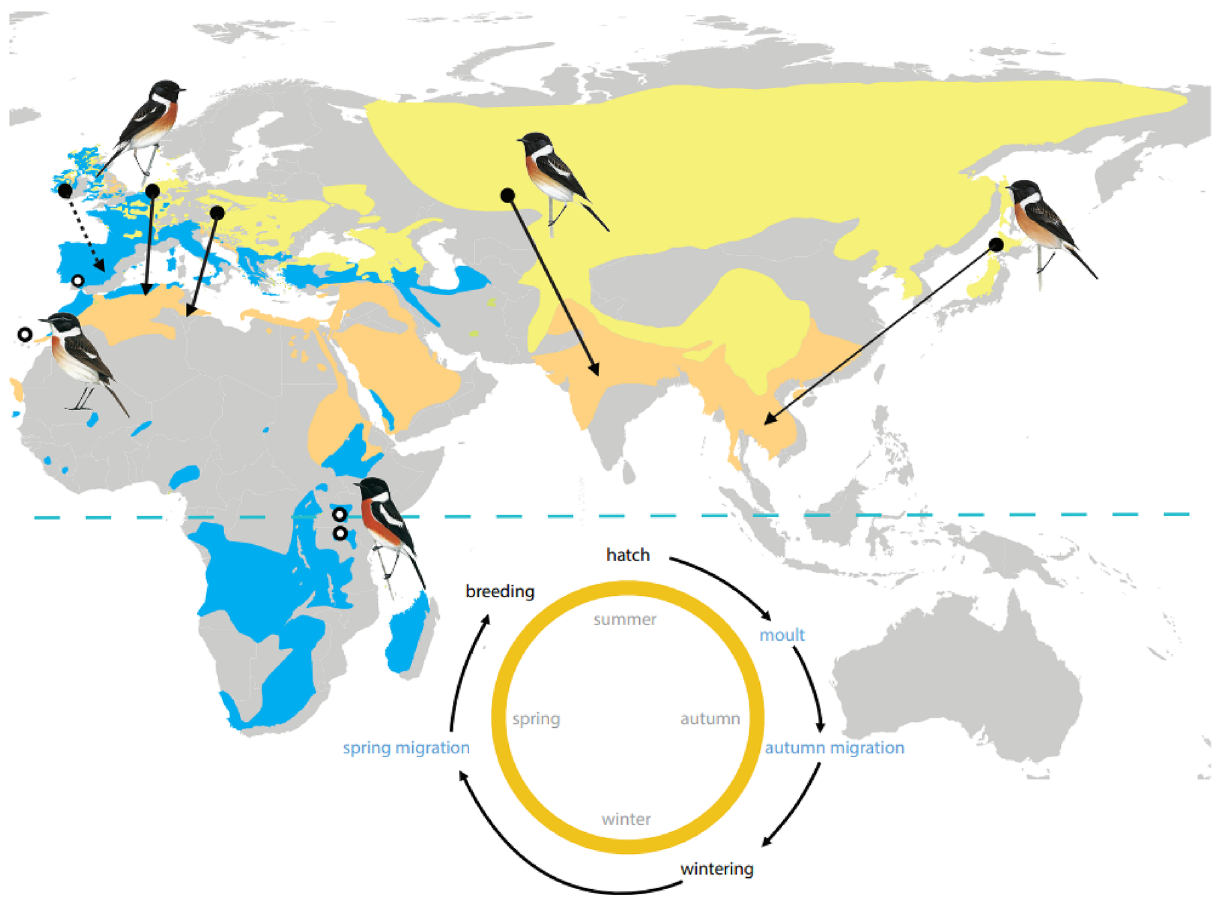
Figure 1. Overview of the geographical distribution and migratory behaviour within the Saxicola complex. Breeding range (yellow) and wintering range (orange) is shown for migrants, year-round range (blue) is shown for residents; the equator is indicated by a dashed blue line. Breeding location is indicated by filled circles for migratory populations and open circles for residents; arrows depict migratory direction and distance (dotted line indicates partial migrants). The circular inlay schematic illustrates key life history events during the first annual cycle of a stonechat’s life, starting with hatching, followed by moult, autumn migration (in case of migrants), wintering period, return migration in spring, and breeding, before the cycle starts all over again. Focal timing events investigated in this study are highlighted in blue. Bird illustrations show the European S. rubicola , the Fuerteventura S. dacotiae , the African S. torquatus , the Siberian S. maurus and the Japanese S. m. stejnegeri 86 taxa.